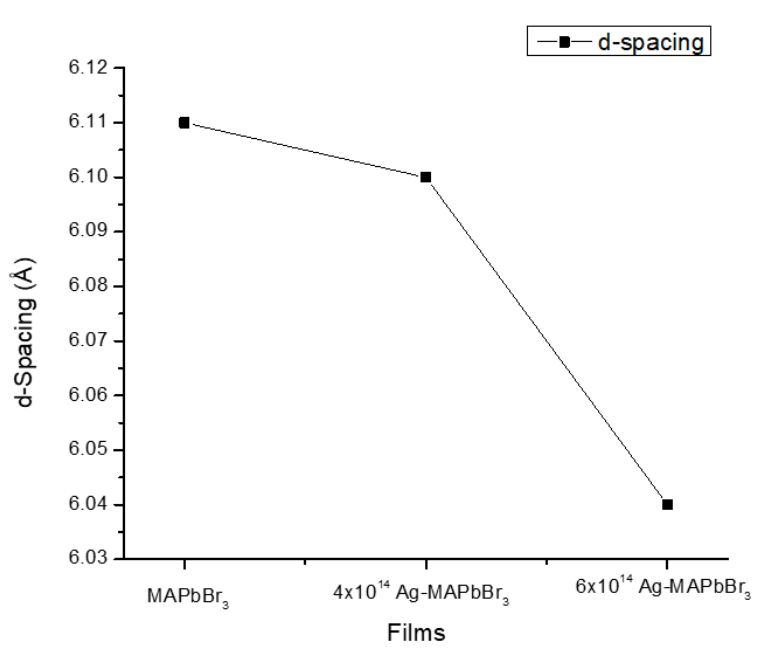
Figure 4. d-Spacing of pure and Ag ion-irradiated MAPbBr 3 films. The values of d-spacing for the (100) peak of the pristine and the 14 4 10 × ions/cm 2 and 6 × 10 (cid:2869)(cid:2872) ions/cm 2 Ag ion-implanted MAPbBr 3 films were 6.11 Å, 6.1 Å, and 6.04 Å, respectively. The measured values showed a cubic crystal behavior according to file num- ber PDF#21–1272 [5,30]. A slight decrease in the d-spacing values was observed by ion implantation. The decrease in d-spacing was due to the fact that Ag has a smaller ionic size. The slightly low value of the d-spacing shows that strong bonding was present be- tween atoms and atoms and between planes and planes in the film’s structure [31]. This will benefit the enhancement of the stability of the structure. 3.1.3. Lattice Parameters and Volume The lattice parameters and volume of a unit cell of pure and Ag-irradiated MAPbBr 3 were calculated using Equations (5) and (6) and are shown in Figure 5. a = d hkl (h 2 + k 2 + l 2 ) 1/2